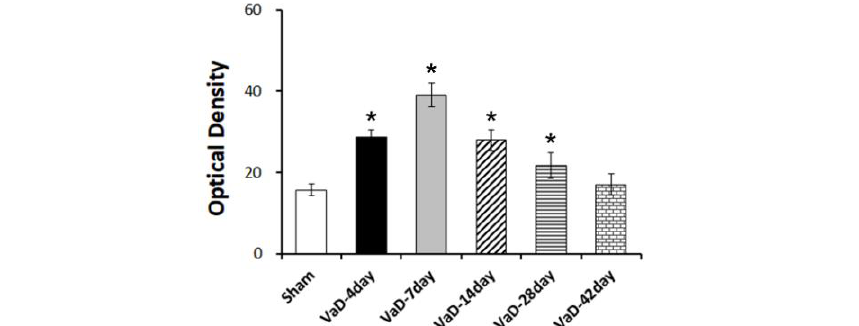
Figure 1. Expression of Lin28a in the hippocampal dentate gyrus after VaD. Representative images of Lin28a expression in the hippocampal dentate gyrus at 4, 7, 14, 28, and 42 days after BCCAO surgery or sham operation. Data are presented as mean ± S.E.M. * p < 0.05, compared to the sham group. A scale bar represents 50 μm .